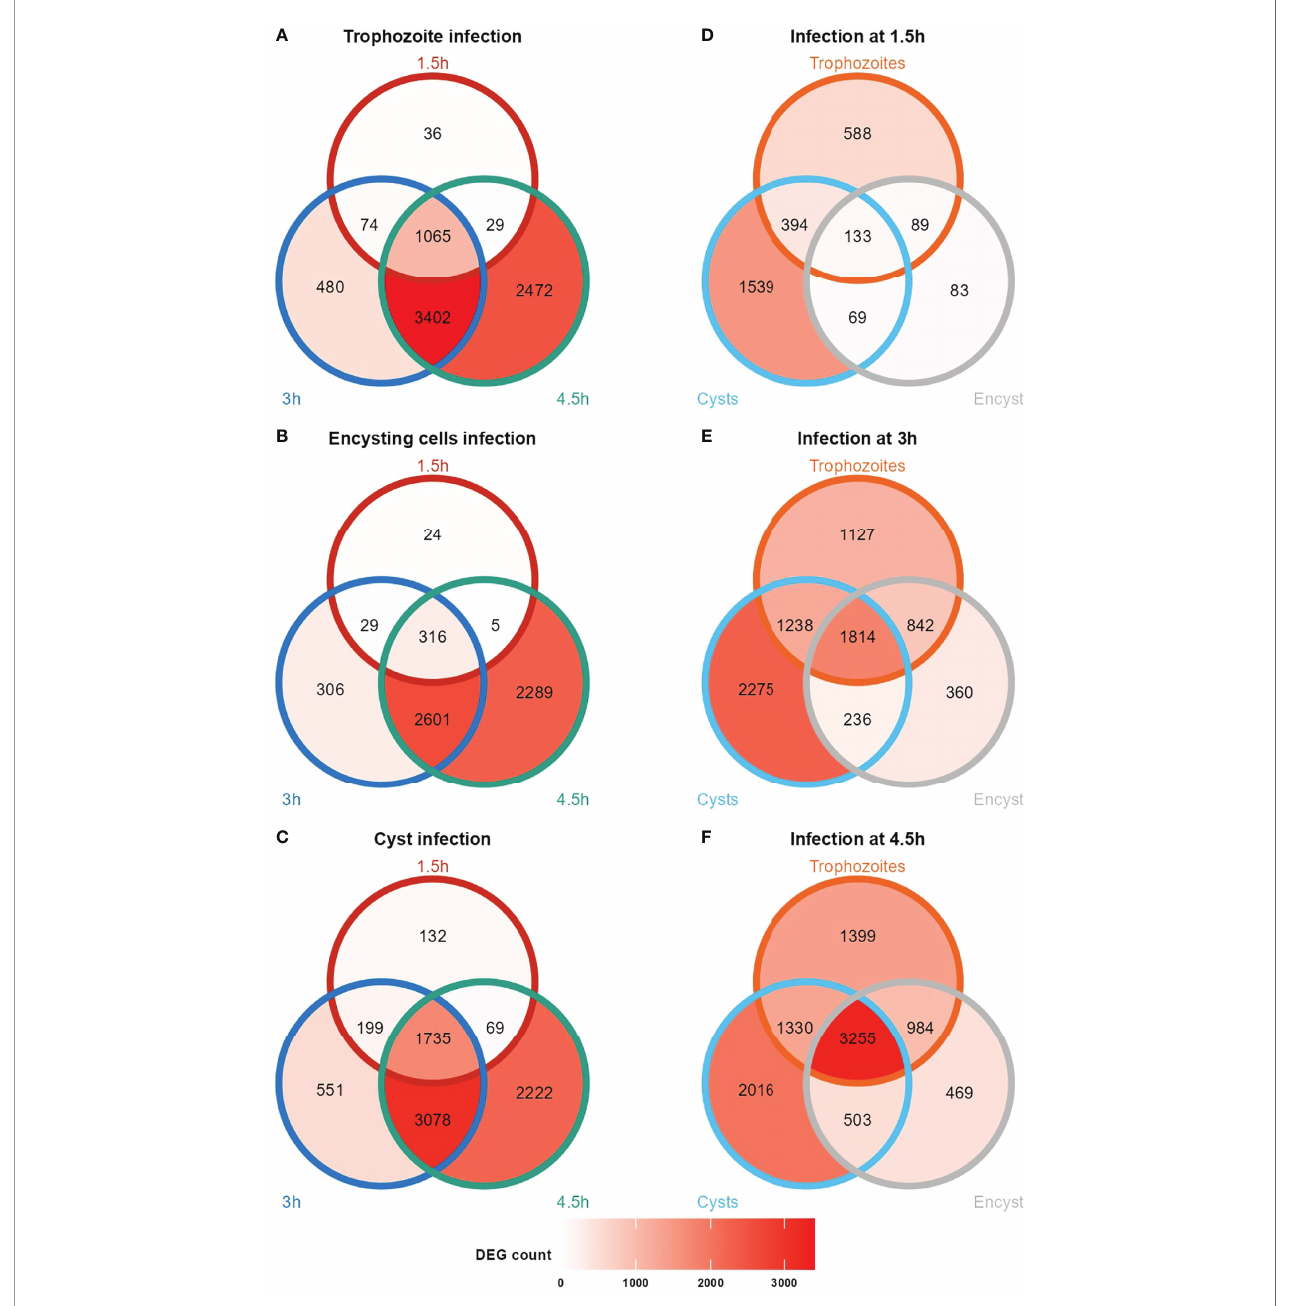
FIGURE 1 | Venn diagrams showing number of differentially expressed human genes at the different time points during Giardia infections of differentiated Caco-2 cells. Caco-2 infection with trophozoites, encysting cells and cysts ( A , B , C , respectively) at timepoints 1.5, 3 and 4.5 h post- infection. Unique and common DEGs at the infection time points (1.5, 3 and 4.5 h post- infection) for the different life cycle stage infections are shown in (D – F) . Encyst, Encysting